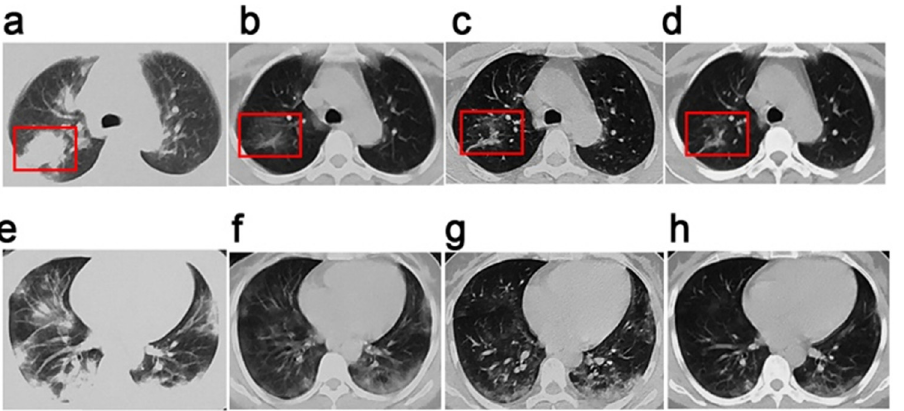
Figure 1: Chest CT images of a 41 - year - old woman with SARS - CoV - 2 infection. Chest CT images for a 41 - year - old woman who presented at Changchun Infectious Diseases Hospital with fever and cough. ( a – d ) Images showing lesions in the posterior segment of the inferior lobe of the right lung. ( a ) Image taken at admission before the onset of treatment showing consolidated opacities in the right lung. ( b and c ) Images obtained on days 4 and 7 showing marked absorption of pulmonary consolidations. ( d ) Image taken on day 10 showing stripe - like opacities indicating recovery of the lung from infection. ( e – h ) Images of the lower lobe of the lung taken, ( e ) , at the onset of treatment, ( f ) , on day 4, ( g ) , on day 7, and ( h ) , on day 10, showing the infection and progressive treatment e ffi cacy. Ground - glass opacities in the pulmonary pleural can be seen to reduce in the lower lobe of the lung from ( e ) to ( h ) .